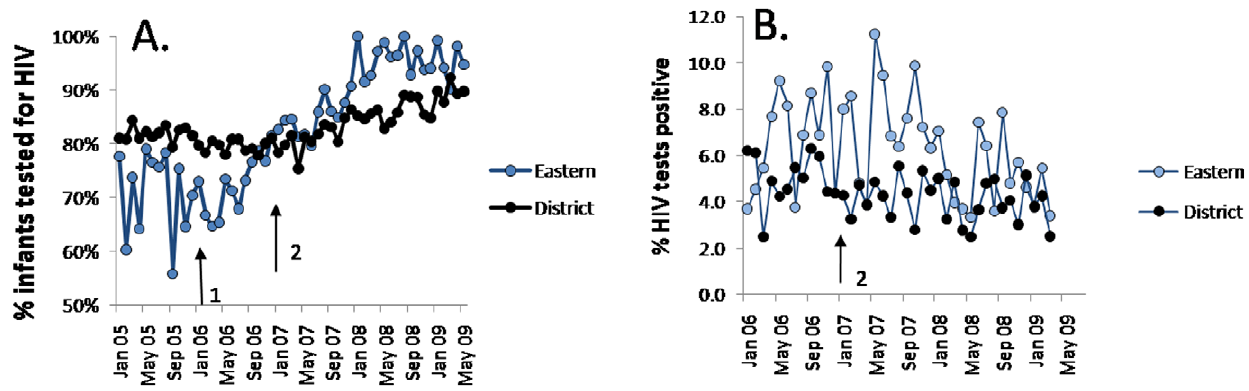
Figure 3. Percentage of infants tested for HIV (A) and percentage of infants testing HIV + (B). Legend: A. Percent of HIV-exposed infants tested for HIV in Eastern sub-district (Eastern) vs. remainder of the Metro District (District) B. Percent of HIV-positive infants in Eastern sub-district vs remainder of Cape Town Metro District . ‘‘1’’=start of the innovation phase, and ‘‘2’’=start of spread phase.